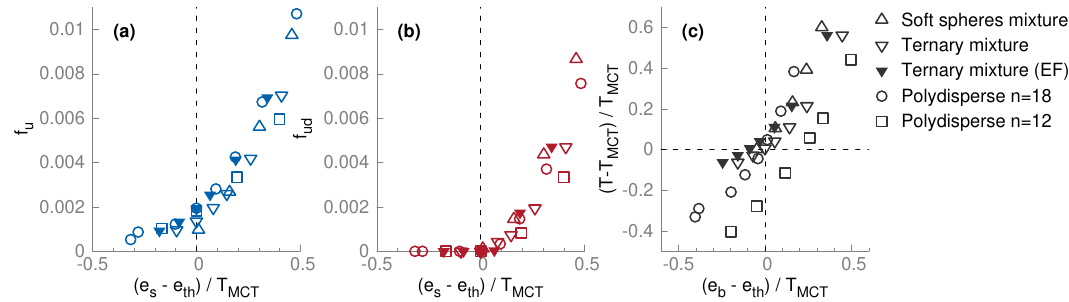
Figure 2: Test of the geometric transition scenario. (a) Fraction of unstable modes f and (b) fraction of delocalized unstable modes f u − e ) / T energy ( e for points obtained from W -minimizations (open symbols) s th MCT and EF optimizations (filled symbols). Temperature is used as an implicit